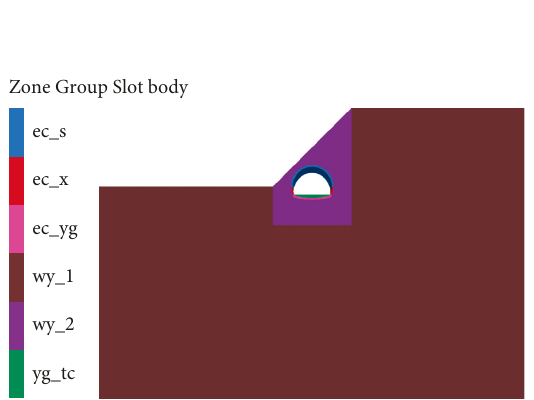
Figure 7: Numerical analysis